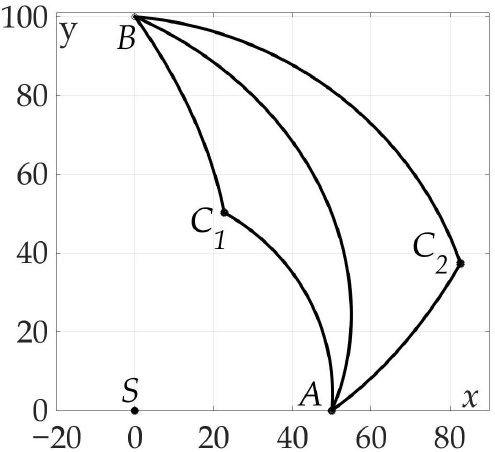
Figure 11. Optimal trajectory on Cartesian